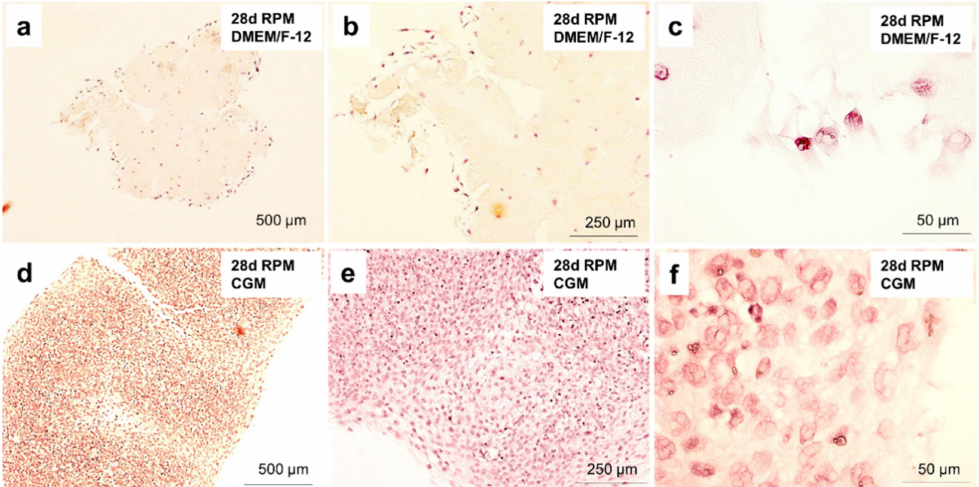
Figure 7. Histological analysis of cartilage-like tissue using Hematoxylin Eosin (HE) staining. ( a ) HE staining of spheroids produced on the RPM during the 28-day-cultivation in DMEM / F-12 medium. ( b ) Closer look at the cell content of the spheroids produced on the RPM during the 28-day-cultivation in DMEM / F-12 medium. ( c ) Closer look at the cell structure of the spheroids produced on the RPM during the 28-day-cultivation in DMEM / F-12 medium. ( d ) HE staining of spheroids produced on the RPM during the 28-day-cultivation in CGM. ( e ) Closer look at the cell content of the spheroids produced on the RPM during the 28-day-cultivation in CGM. ( f ) Closer look at the cell structure of the spheroids produced on the RPM during the 28-day-cultivation in